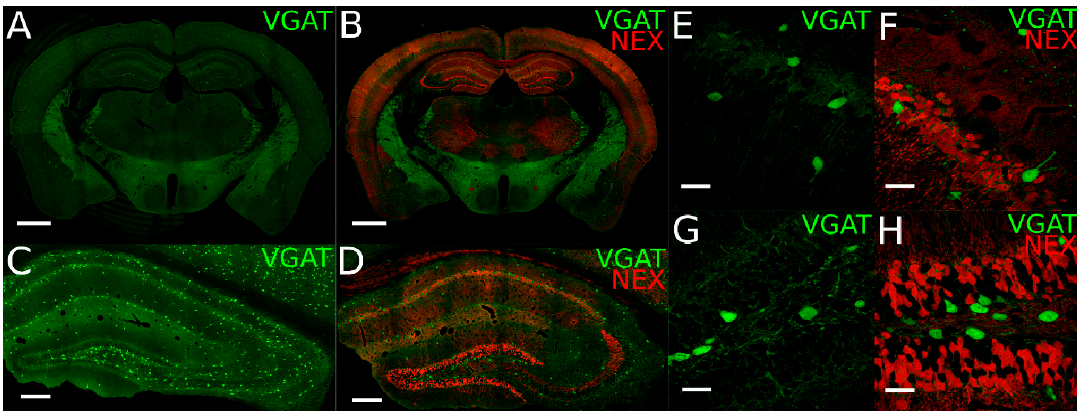
Figure 1. Identification of hippocampal glutamatergic principal cells (PCs) and GABAergic interneurons (INs) in transgenic mouse lines. ( A,B ) Overview images of the yellow fluorescent protein (YFP; green pseudocolor) and red fluorescent protein (RFP; red) reporter signals expressed under the VGAT and NEX (neuronal helix-loop-helix protein) promoters, respectively, in coronal brain slices of (A) single VGAT-YFP and (B) VGAT-YFP x NexCre-Ai9 transgenic mouse lines. ( C , D ) Zoomed-in images of the dorsal hippocampus showing either (C) endogenous YFP fluorescent signal for GABAergic neurons or (D) the YFP and RFP fluorescent signal for both GABAergic and glutamatergic neurons. ( E – H ) High-power confocal images of hippocampal CA1 area (E,F) and the dentate gyrus (DG; G,H) illustrating the distribution of GABAergic and glutamatergic neurons in the two transgenic lines. Scale bars: (A,B), 1000 µ m; (C,D), 200 µ m; (E–H), 30 µ m.